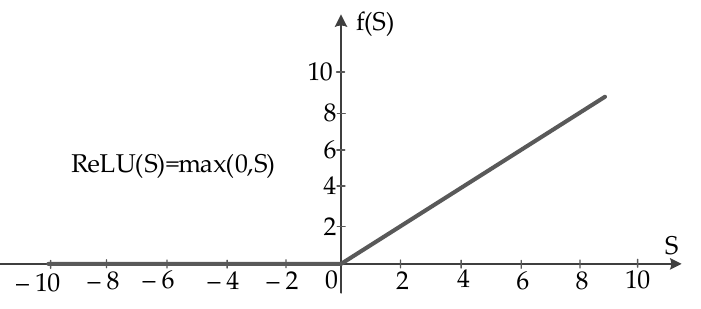
Figure 7. Activation function ReLU.